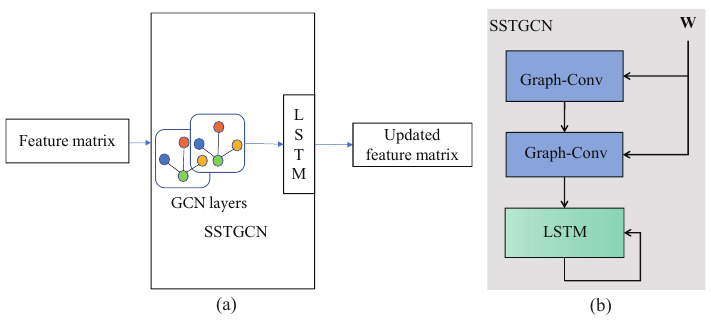
Figure 3. Framework of SSTGCN. ( a , b ) show the structure of SSTGCN, consisting of two-layer graph convolution and LSTM. ( a ) shows the flow in which the characteristic matrix is processed. ( b ) shows the internal calculation process of